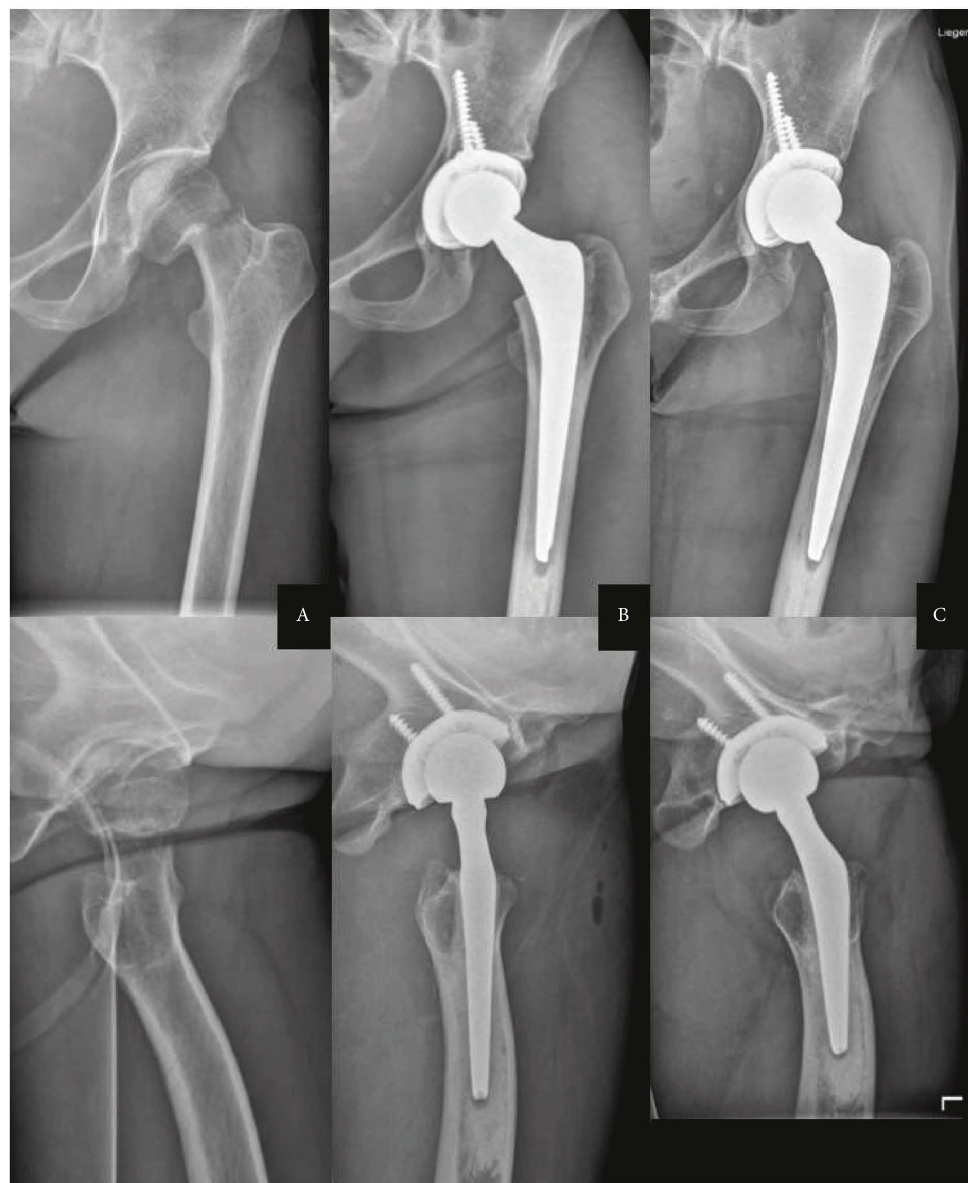
Figure 1: Anteroposterior and axial radiographs of the left hip from case one at the time of the dislocated stress fracture of the femoral neck (a) on the second postoperative day after hybrid THA (b) and at the one-year mark (c) Several months after untreated acute PJI with S. aureus the implants are well fixed, in particular, the cup is fully integrated. Note thinning out of the cancellous bone in the proximal femur as well as of the cortical bone on the femoral diaphysis, with an enlarged medullary cavity, indicating osteoporosis. The patient suffered from refractory anorexia